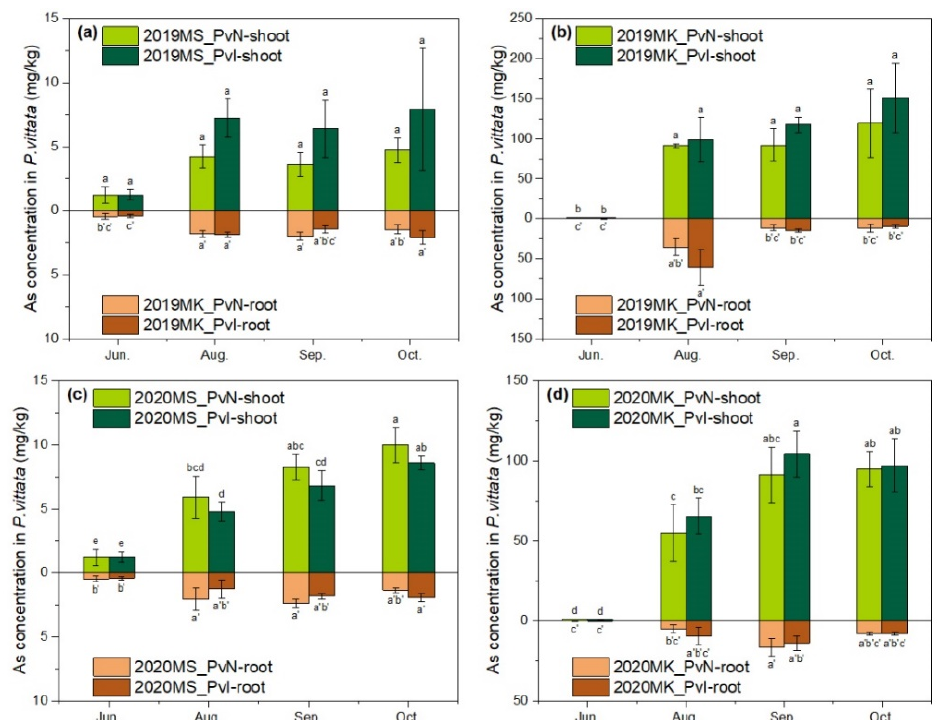
Figure 3. Arsenic concentration in shoot and root of P. vittata in ( a ) site MS in 2019 ( b ) site MK in 2019 ( c ) site MS in 2020 ( d ) site MK in 2020. Data with different letters indicated significant differences ( p < 0.05) according to ANOVA by Tukey HSD test.